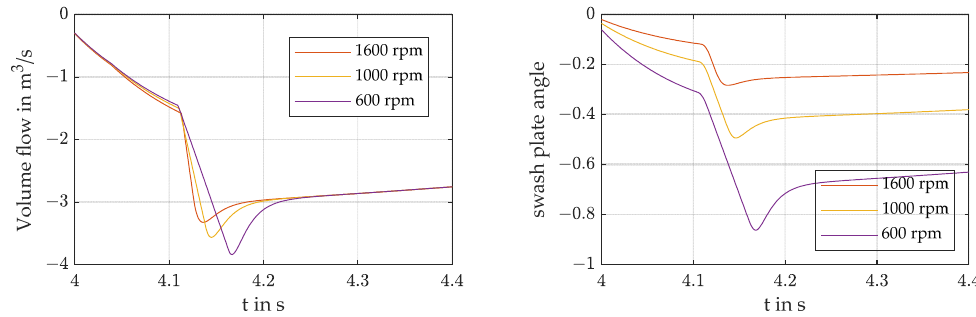
Figure 9. Volume flow and swash plate angle for different motor speeds during force build-up.